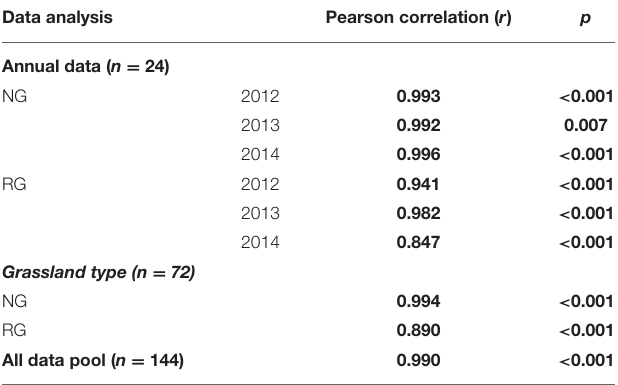
TABLE 5 | Correlations between the ratio of root and belowground biomass in the natural (NG) and restored (RG) alpine grasslands around Qinghai Lake